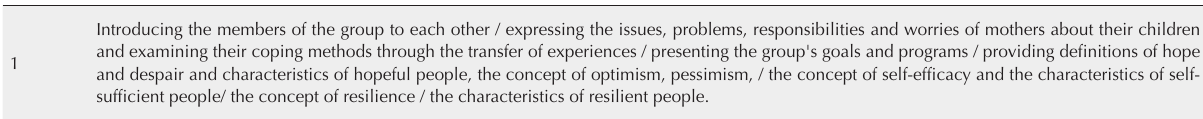
Table 1. Summary of psychological capital training sessions Sessions Session